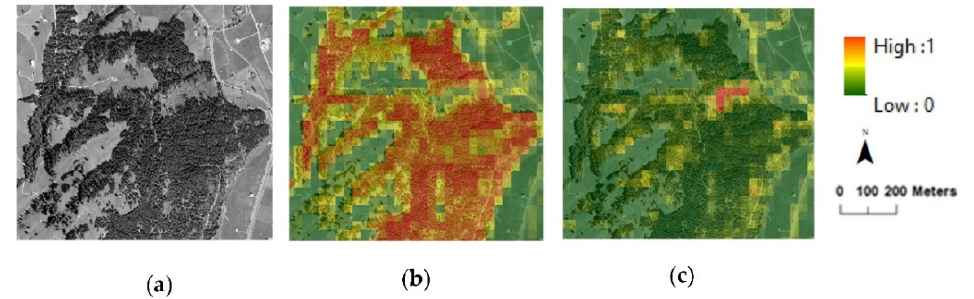
Figure 5. ( a ) B&W aerial image of the study area 1 (Img_T2 from 2010), ( b ) layer of percentage of Canopy Cover (CC) for pixels greater than 5 m, ( c ) percentage of CC for pixels in the height range of 3–5